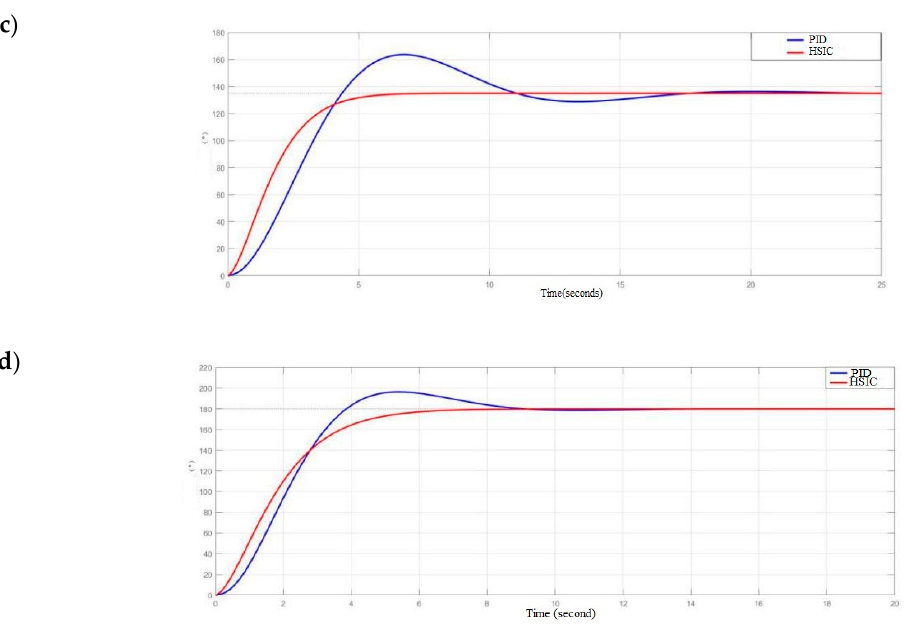
Figure 9. Target course control comparison test ( a : 45°; b : 90°; c : 135°; d : 180°).